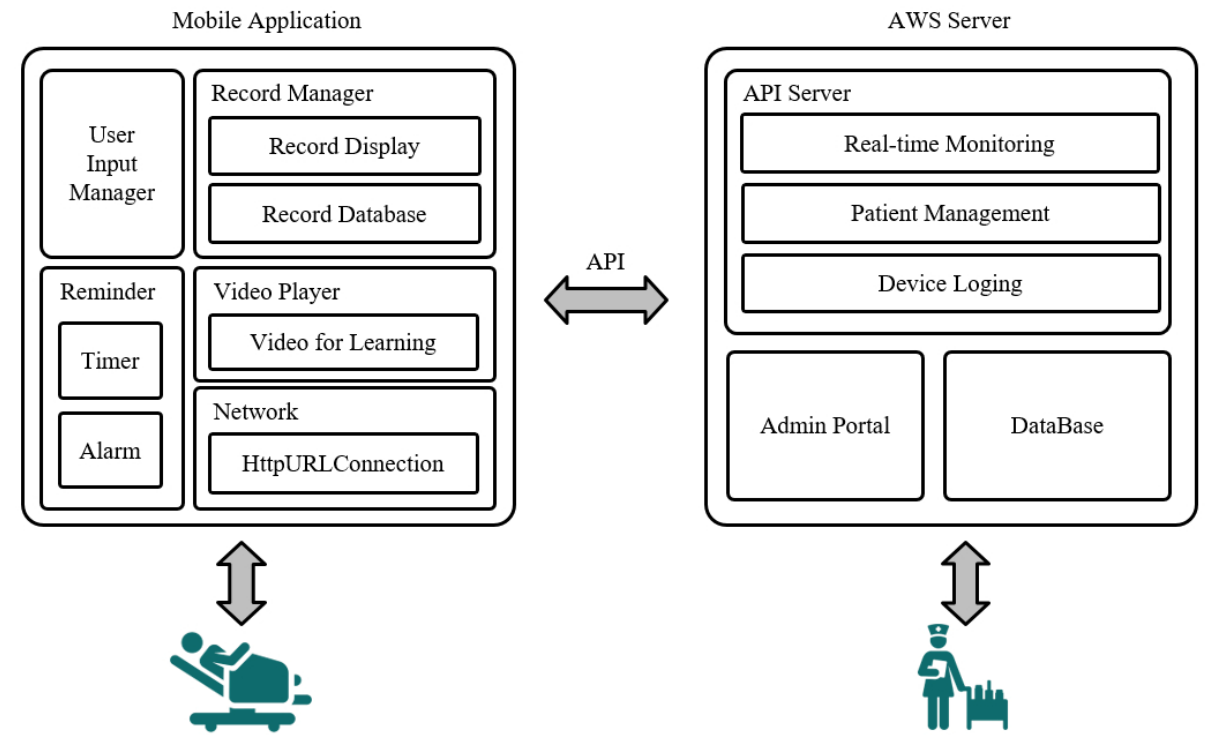
Figure 3. System architecture. API: application programming interface; AWS: Amazon Web